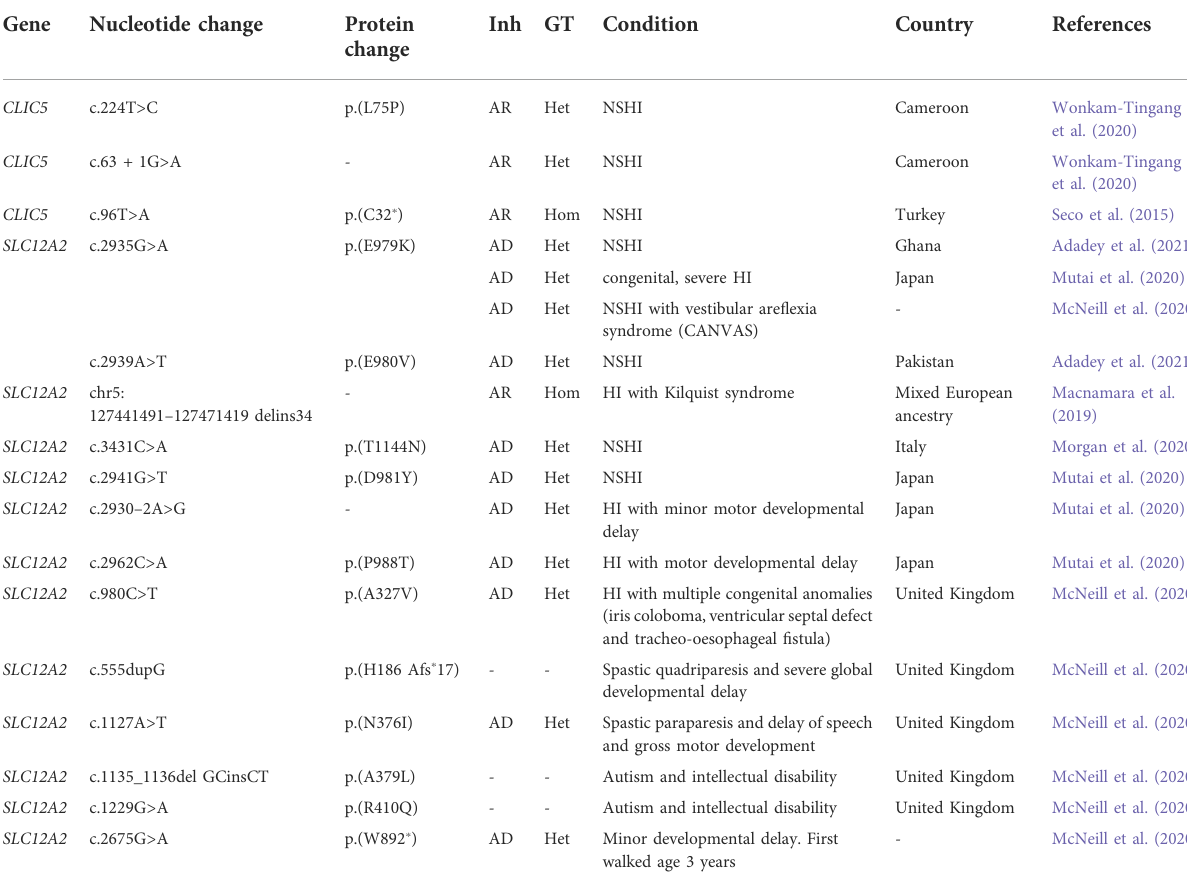
TABLE 1 Association of CLIC5 and SLC12A2 variants with hearing impairment in